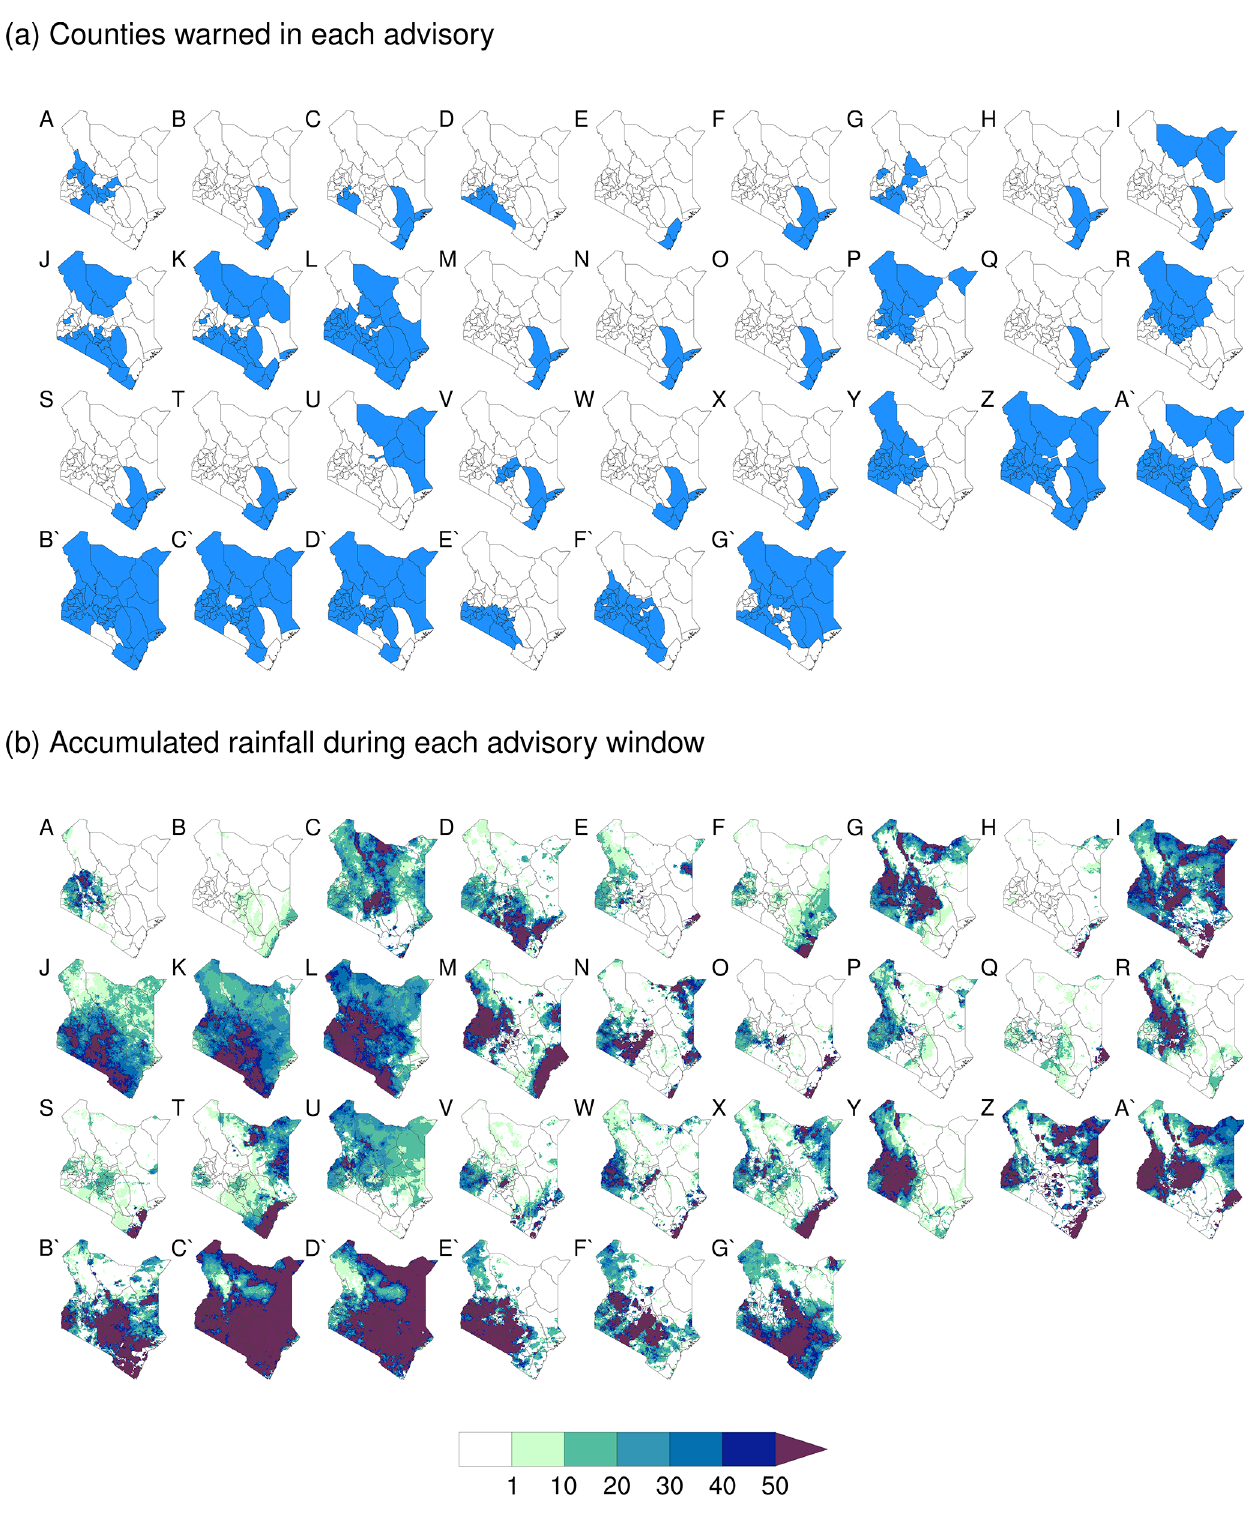
Figure 3. (a) Counties with active warnings for each of the 33 heavy rainfall advisories issued by the KMD during 2015–2019 (advisory details are given in Table 1). (b) Rainfall accumulations (mm) during each advisory window, based on